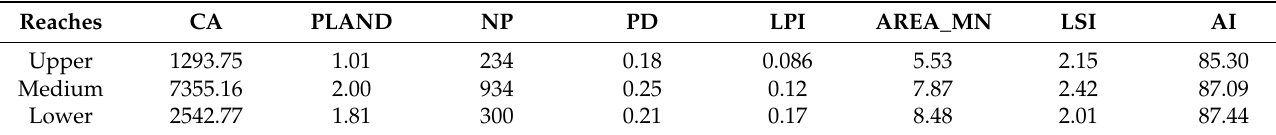
Table 3. Landscape pattern index of rural settlements in the Lijiang River